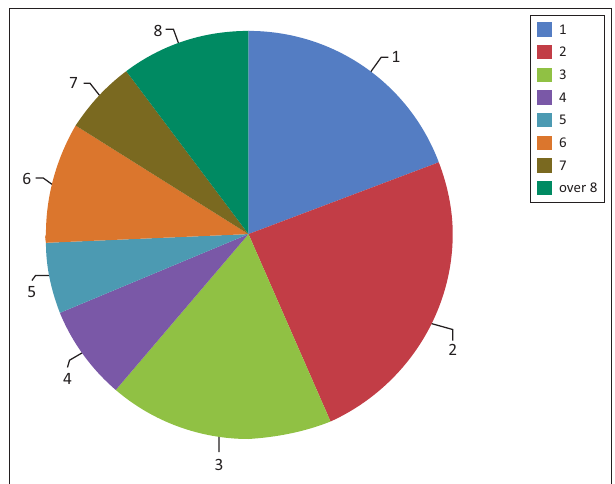
FIGURE 3: Experience within the company